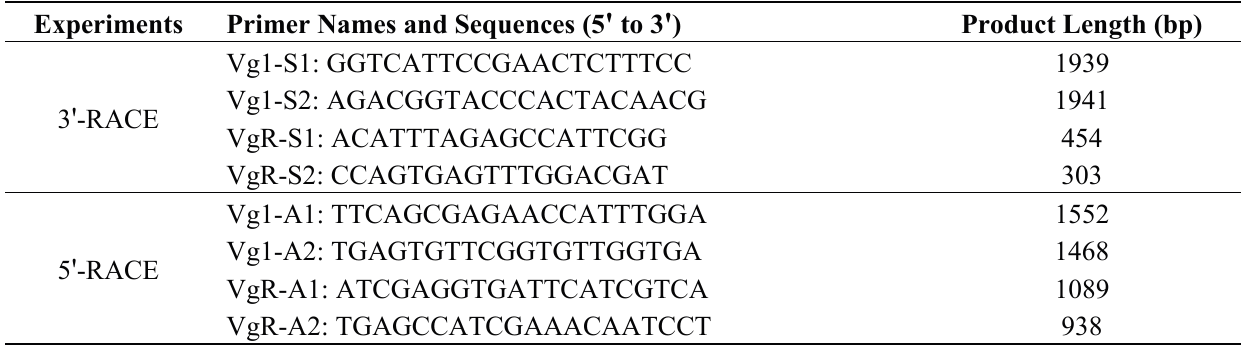
Table 1. Primers used for